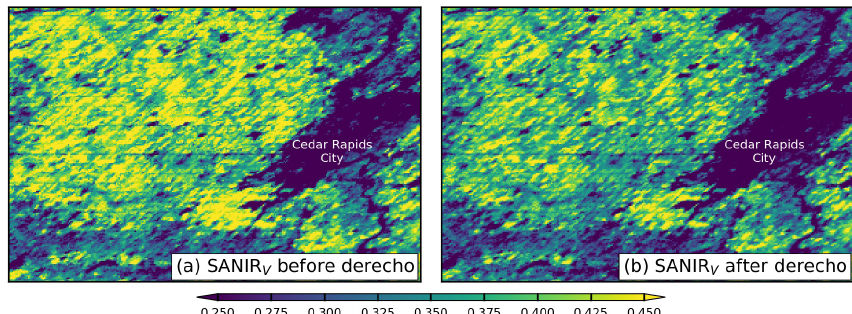
Figure 5. SANIR V in a 50 × 75km 2 area at Cedar Rapids, Iowa (red marker in Fig. 4a), on (a) 9 Aug 2020 and (b) 13 Aug 2020. A severe derecho took place from 10–11 August 2020. The maps are shown with the sinusoidal